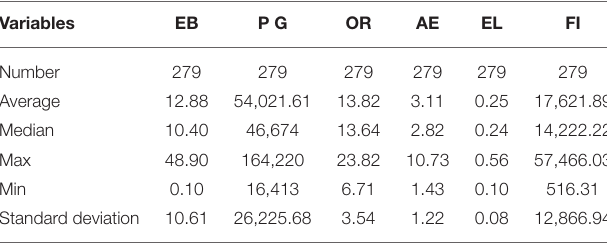
TABLE 2 | Descriptive statistical analysis of related variables. TABLE 3 | The impact of instrument mix of different policies on the facility input of care institutions for older